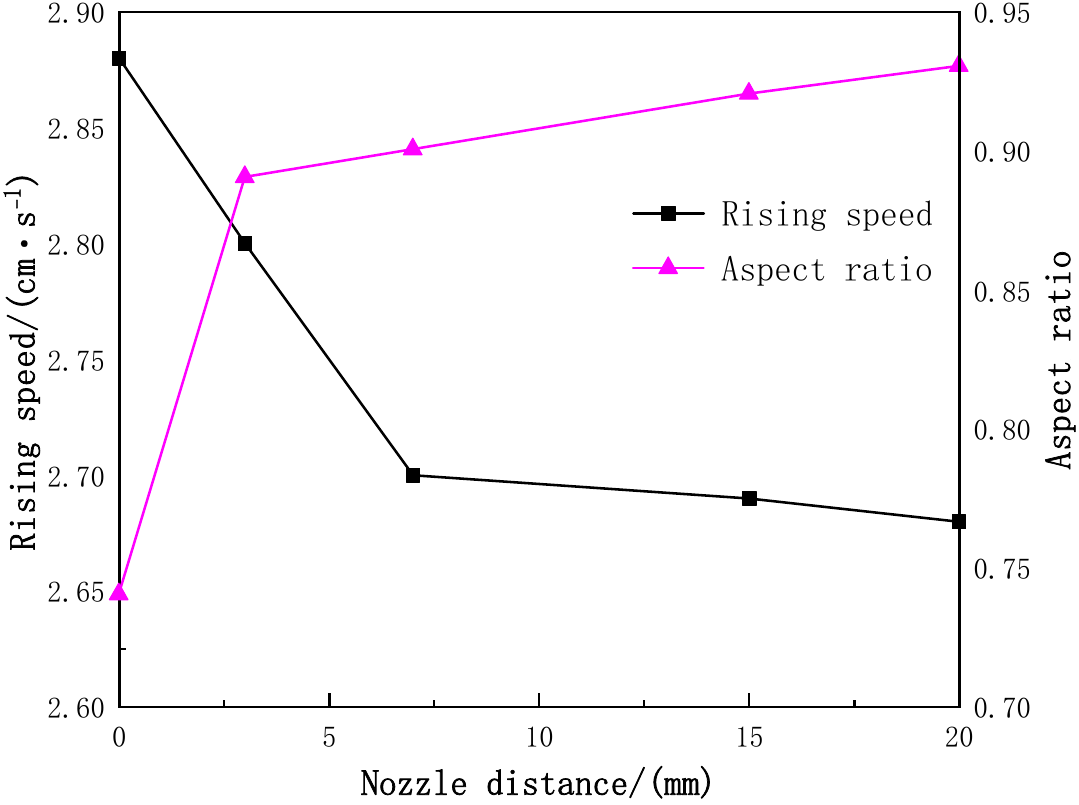
Figure 9. Effect of tube-nozzle distance on bubble aspect ratio and rise velocity.